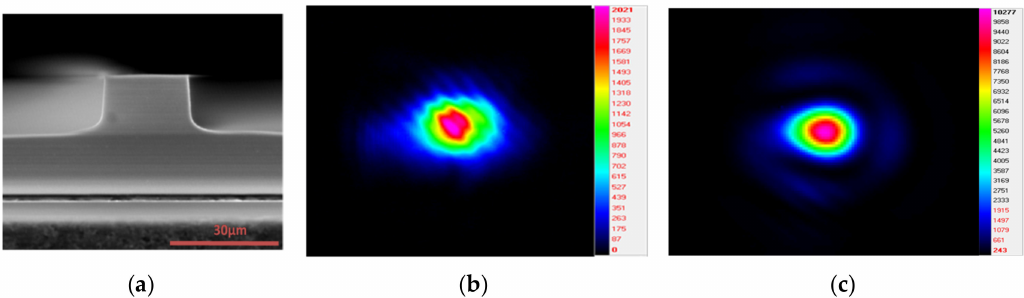
Figure 4. ( a ) ESEM cross section of a diced ridge waveguide. ( b , c ) show the near field distribution of Gaussian input and output beam (3.68 µ m) coupled and that obtained from the end face of the tapered waveguide, respectively.